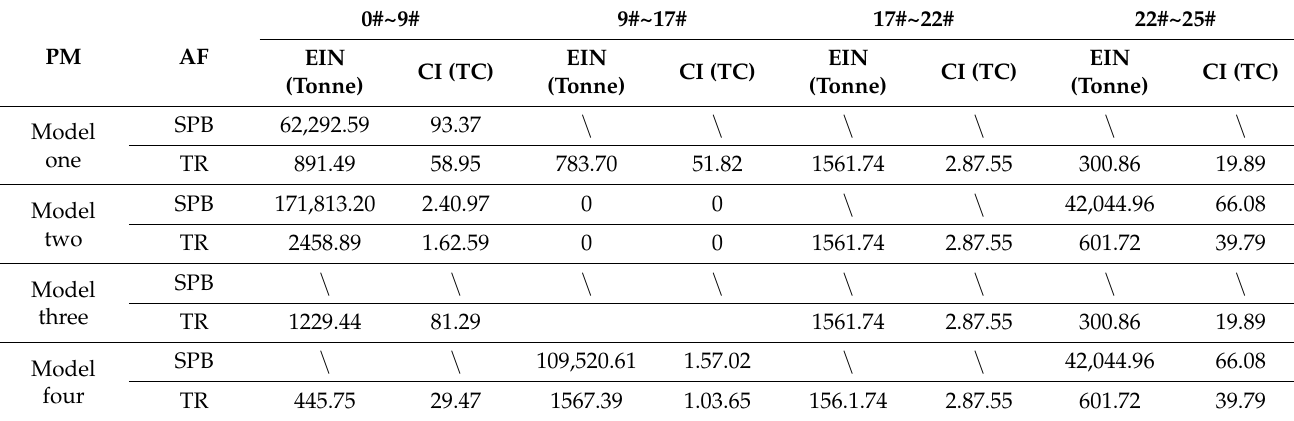
Table 5. Data of steel pipe support and temporary